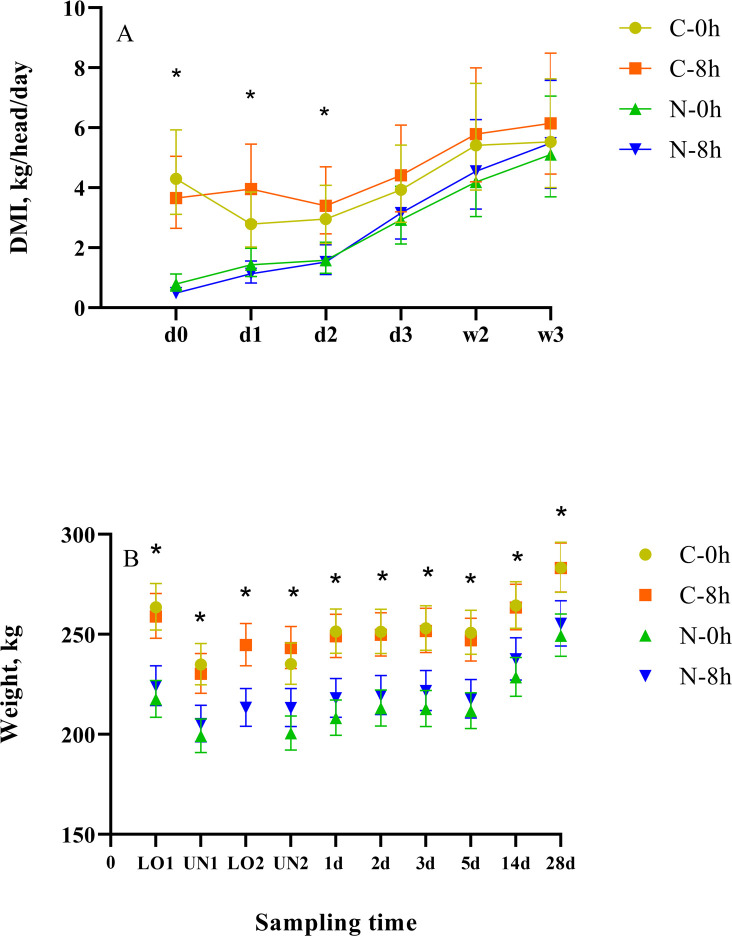
Least squares means (± upper and lower limits) of (A) DMI and (B) body weight of conditioned (C) and non-conditioned (N), auction market (A) and ranch direct (R) calves rested for 0 (0 h) or 8 (8 h) h.